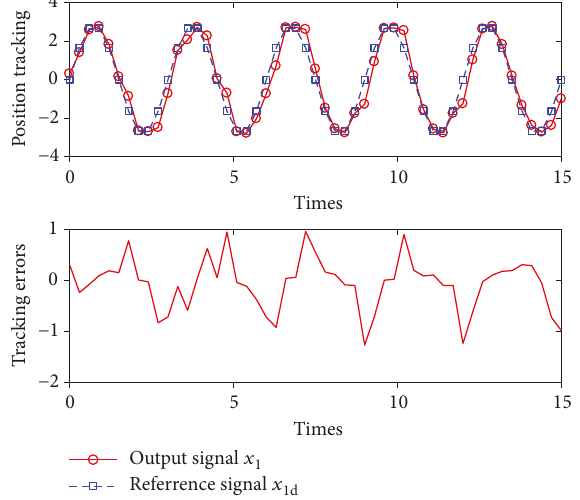
with y = 2 4 d Figure 9: The control results and tracking error of x 2 8 sin 2/3 π t .